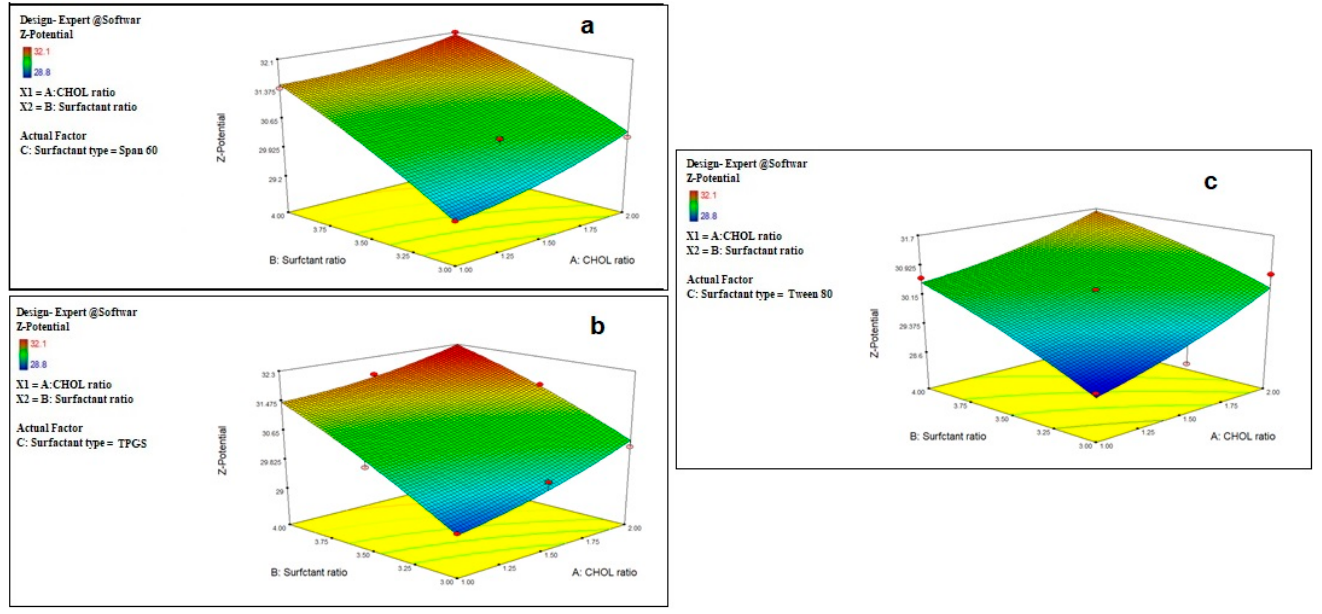
Figure 1. Effect of CHOL and surfactant ratio on the particle size of drug-free niosomes at different surfactant types (( a ): Span 60, ( b ): TPGS, ( c ): Tween 80).